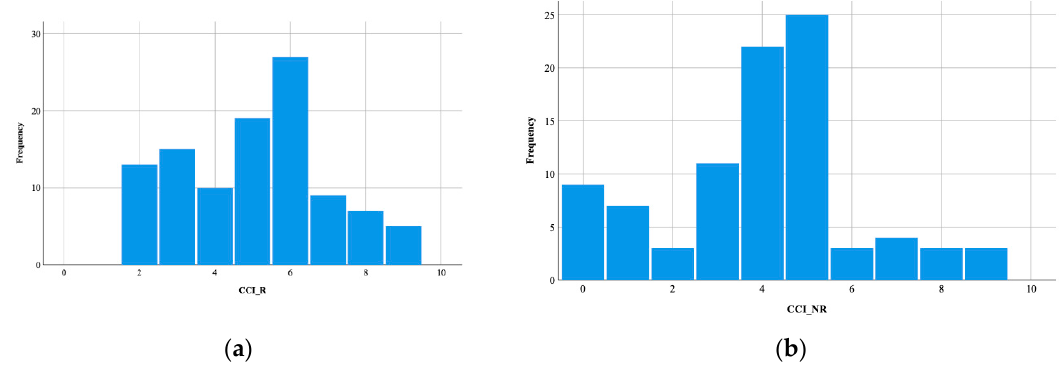
Figure 3. Histogram of values of Charlson Comorbidity Index: ( a ) in the recurrent group; ( b ) in the non-recurrent group. CCI_R—Charlson Comorbidity Index in the in the recurrent group, CCI_NR—Charlson Comorbidity Index in the non-recurrent group.